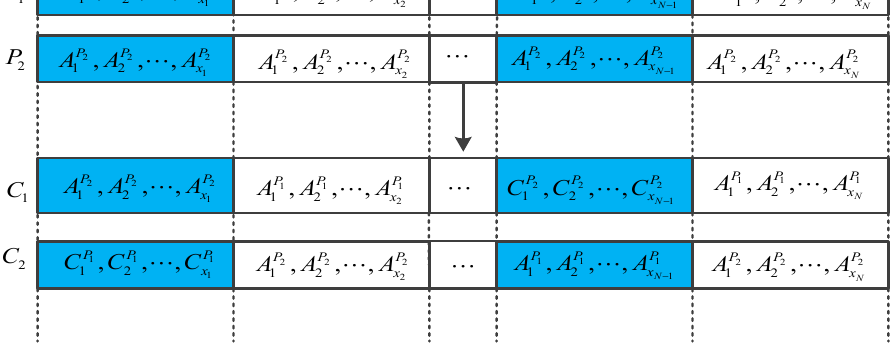
Figure 2. The crossover process case Z ≥ x i − 2.